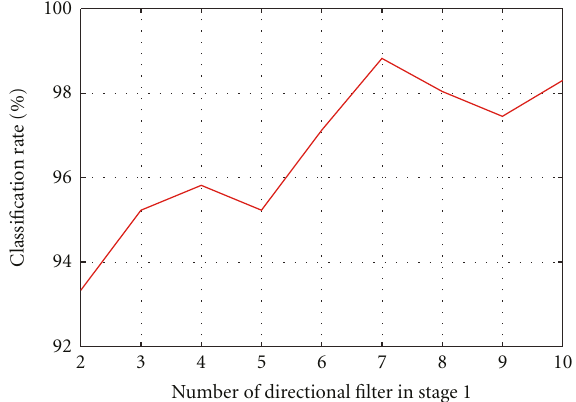
Figure 5: Classification rate with respect to the number of directional filters in Stage